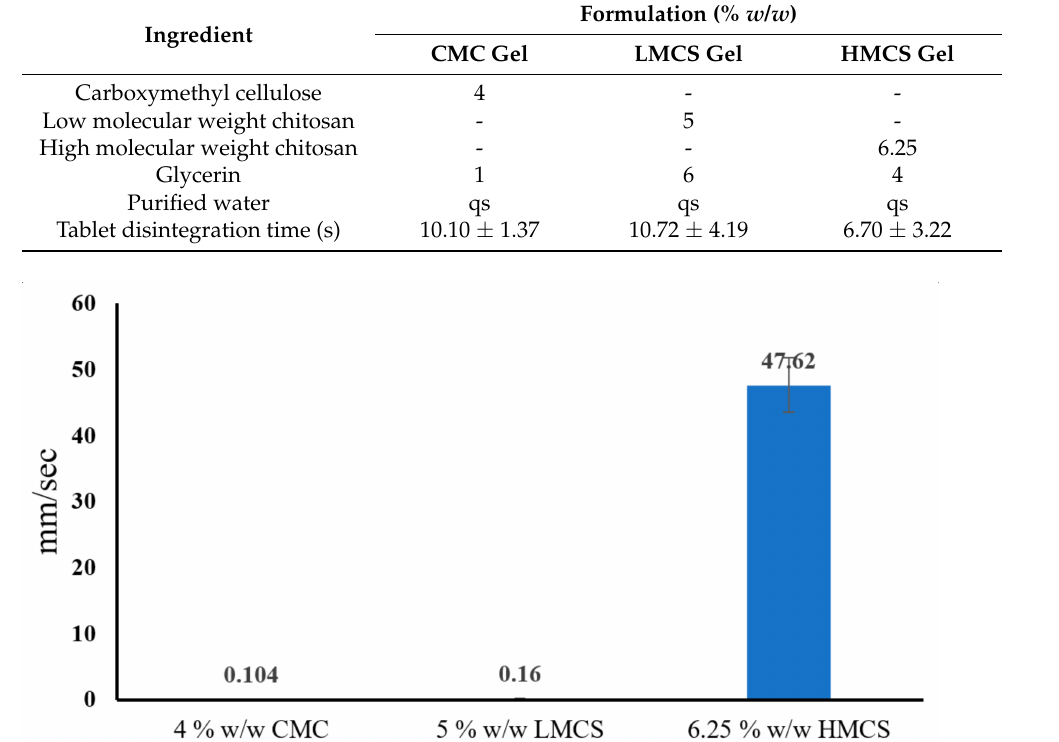
Figure 8. Flow rate of the selected pill swallowing gel formulations from the tablet-through-a-tube test (carboxymethyl cellulose; CMC, low molecular weight chitosan; LMCS, and high molecular weight chitosan;